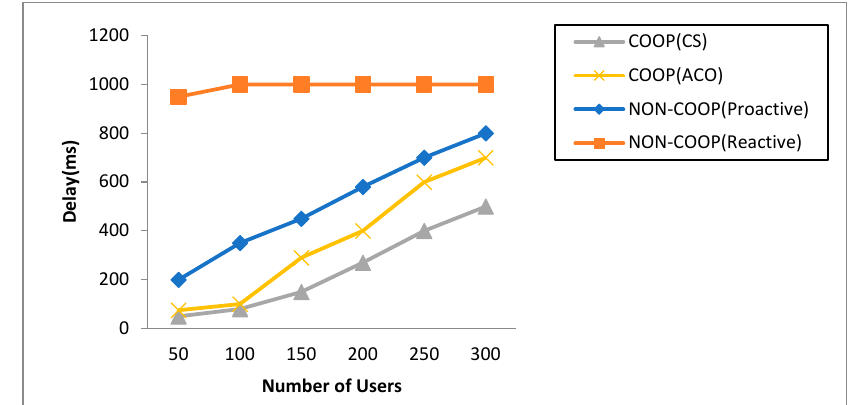
Figure 13. Delay with the increasing number of users.